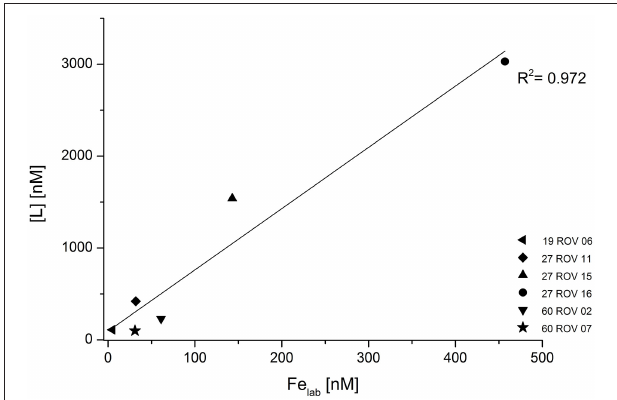
FIGURE 7 | Fe binding ligand concentrations ([L]) plotted against labile Fe (Fe lab ) for all hydrothermal samples collected with the